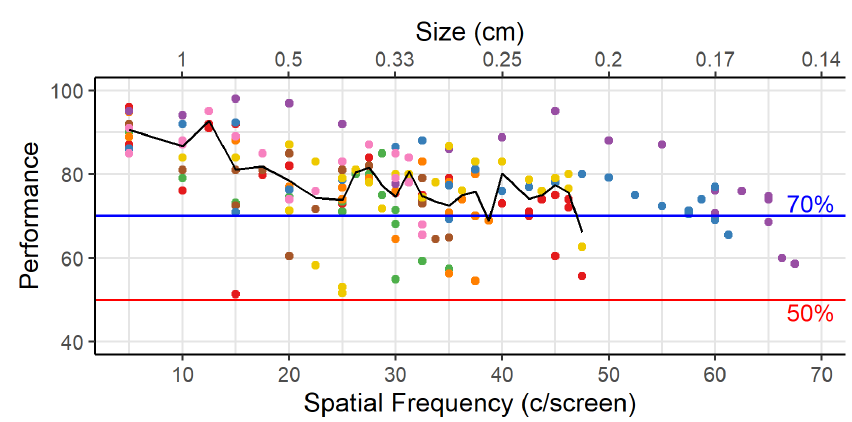
Figure 3. Testing phase. Average (–) and individual ( ◦ ) performance per session during the testing phase (starting from the last 2 days with 5 c/screen). Colors as in Figure 2A. After 50 c/screen the average is no longer indicated as only two animals are still